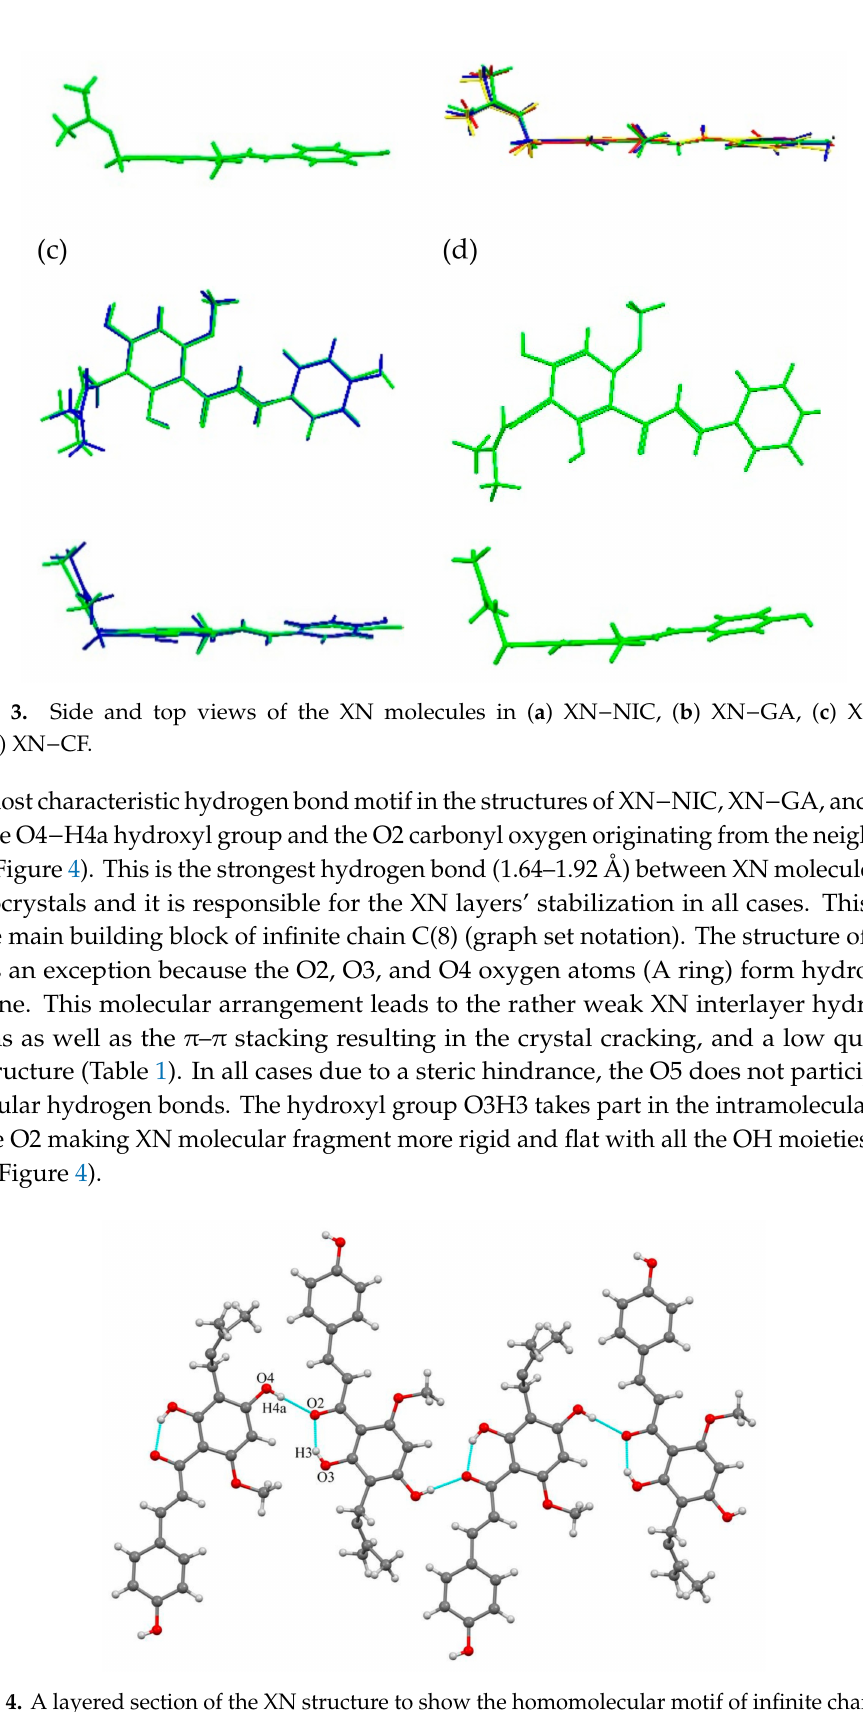
Figure 4. A layered section of the XN structure to show the homomolecular motif of infinite chains C(8) observed in the layers of XN molecules for the XN − NIC, XN − GA, and XN − AC